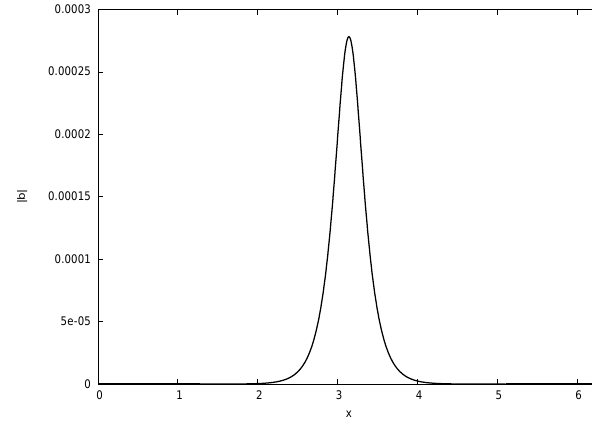
Fig. 1. Real part of b(x) with V = 1 / 16 and (cid:127) = 4 . 01. Figure 1. Real part of b ( x ) with V = 1 / 16 and Ω = 4 . 01.